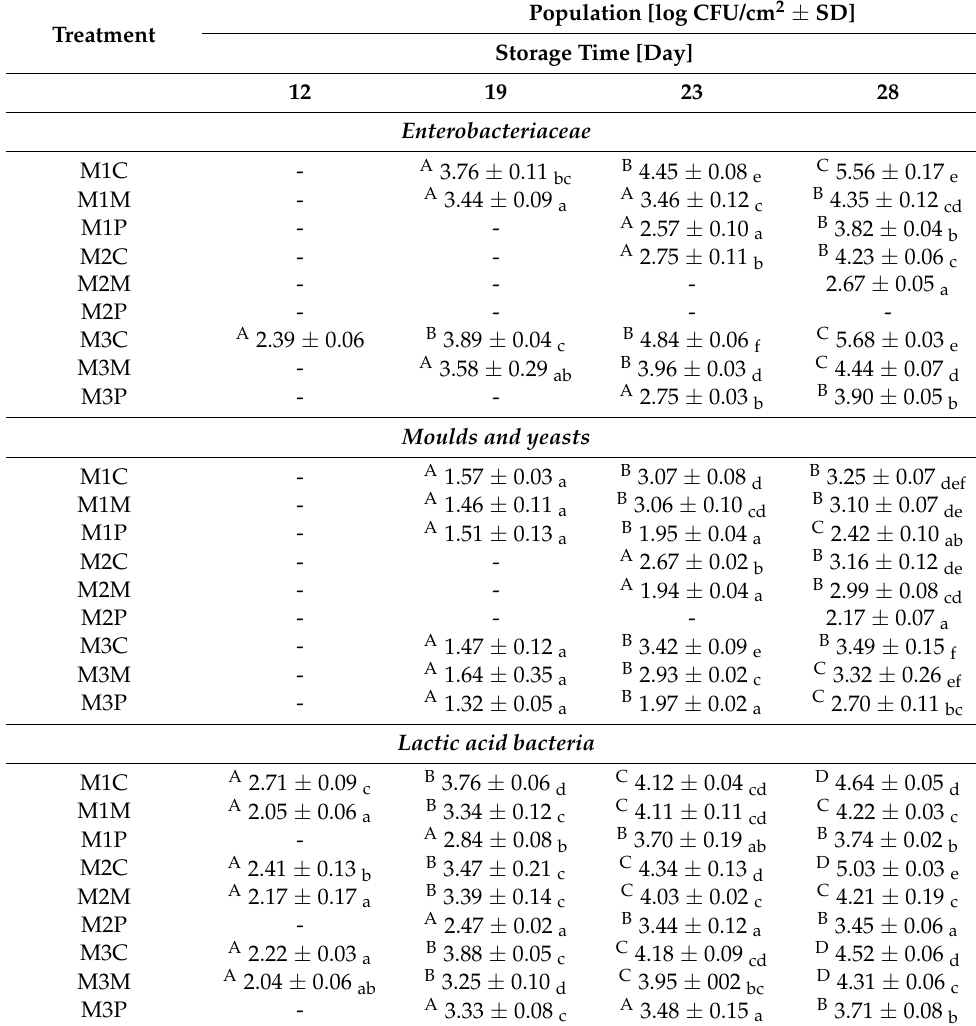
Table 2. The effect of lysozyme and modified atmosphere on Enterobacteriaceae , moulds and yeasts and lactic acid bacteria in pork stored at 4 ◦ C ± 1 ◦